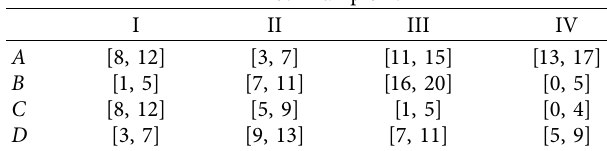
Table 3: Example 1.